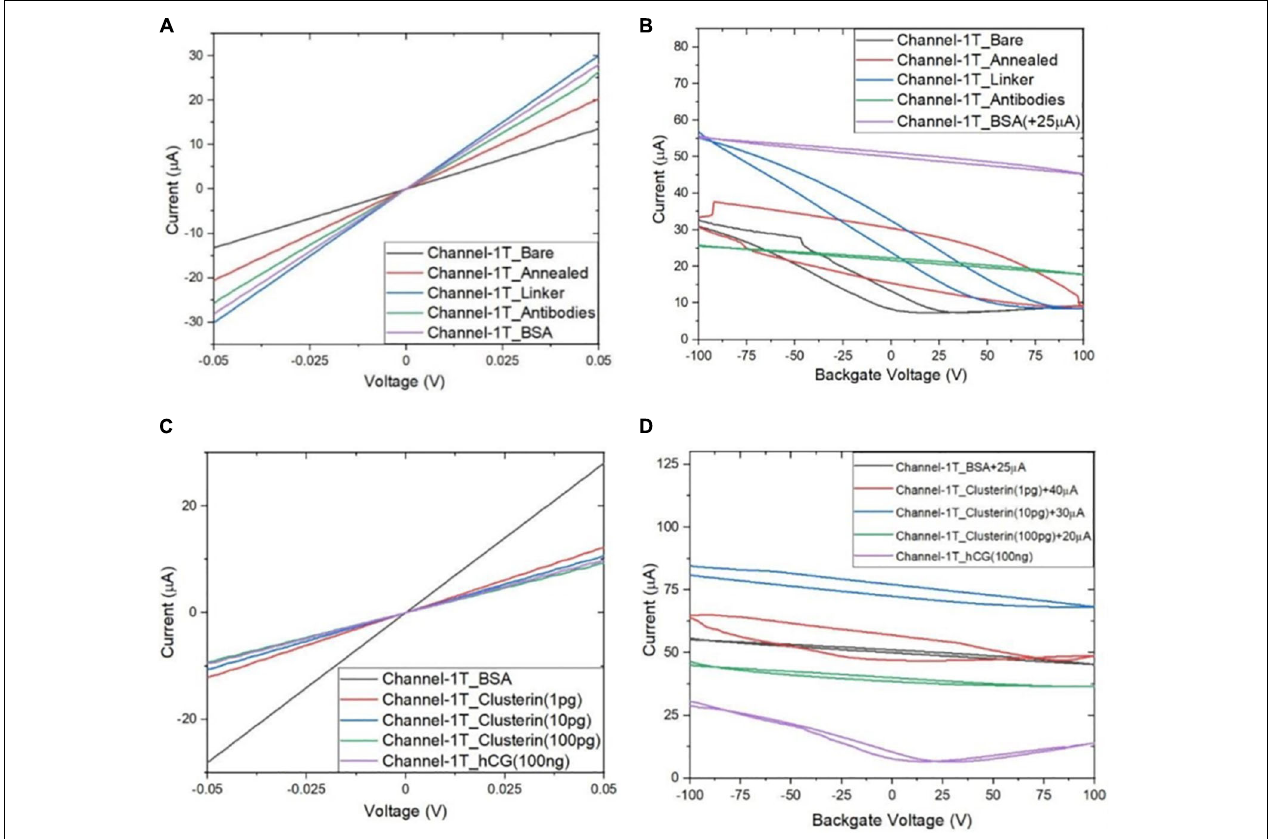
FIGURE 9 | Characteristic curves for Channel-1T (A) I D –V D output curves for bare to BSA, (B) I D –V G transfer curves for bare to BSA, (C) I D –V D curves for BSA to hCG (100 ng/mL), and (D) I D –V G curves for BSA to hCG (100 ng/mL), with off-set currents shown for clarity. Antigen concentrations are in units of